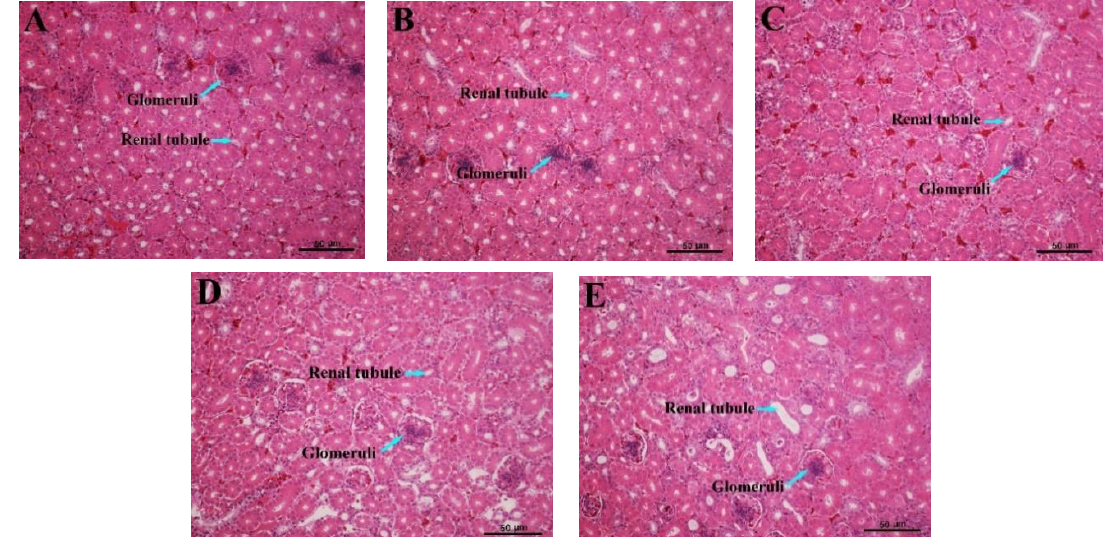
Figure 6. Renal histomorphology from various experimental groups of laying hens. The kidney